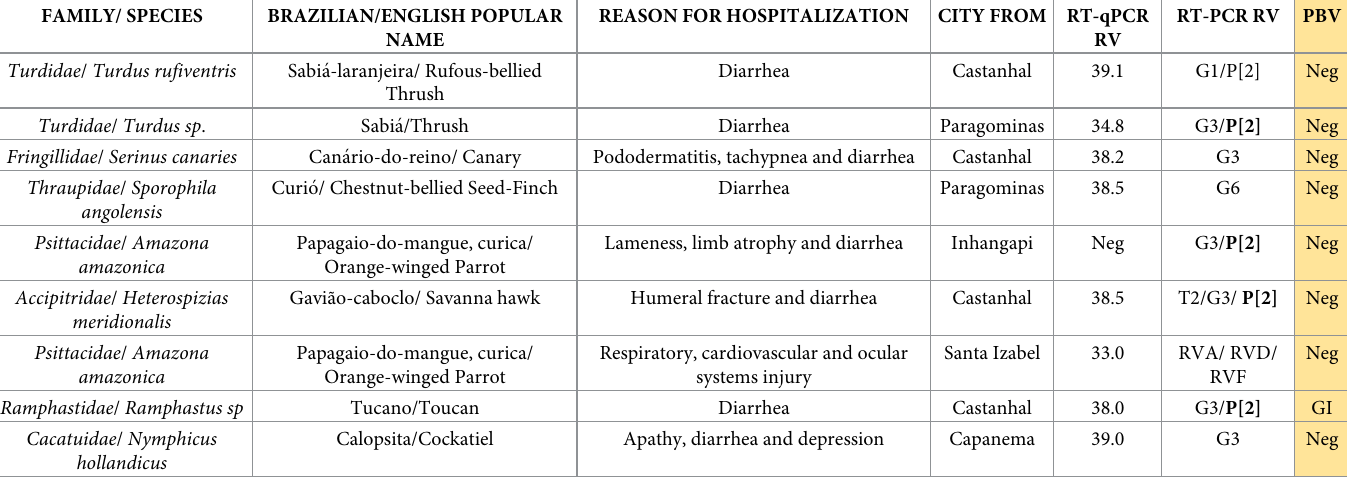
Table 3. Positive RV and PBV samples from animals hospitalized at the Veterinary Hospital of the Federal University of Para´, Brazil. FAMILY/